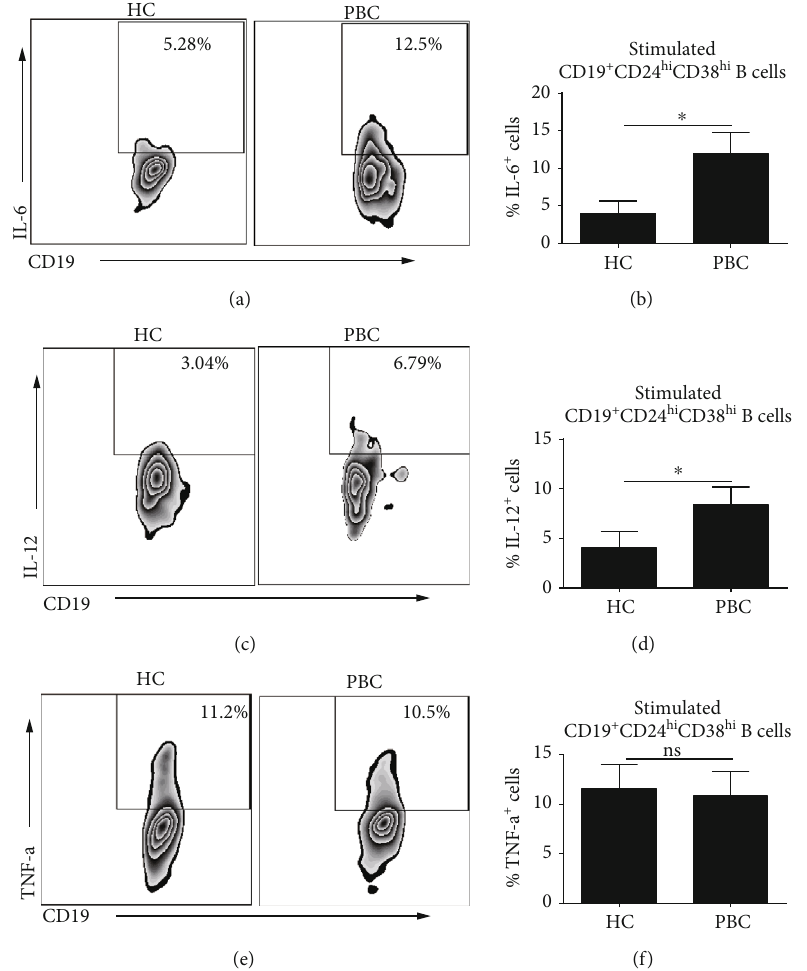
Figure 5: CD19 + CD24 hi CD38 hi B cells from PBC patients express greater amounts of IL-6 and IL-12 when stimulated with anti-BCR and CpG. PBMC were stimulated with CpG and anti-BCR for 48h plus phorbol ester, ionomycin, and Brefeldin A (last 5h). (a, c, e) Each representative dot plot shows the frequency of IL-6, IL-12, or TNF- α within the CD19 + CD24 hi CD38 hi B subset from PBC or HC. (b, d, f) Cumulative frequency of IL-6-, IL-12-, or TNF- α -producing cells within the CD19 + CD24 hi CD38 hi B subsets from PBC patients or HC subjects; ∗ P < 0 : 05 .